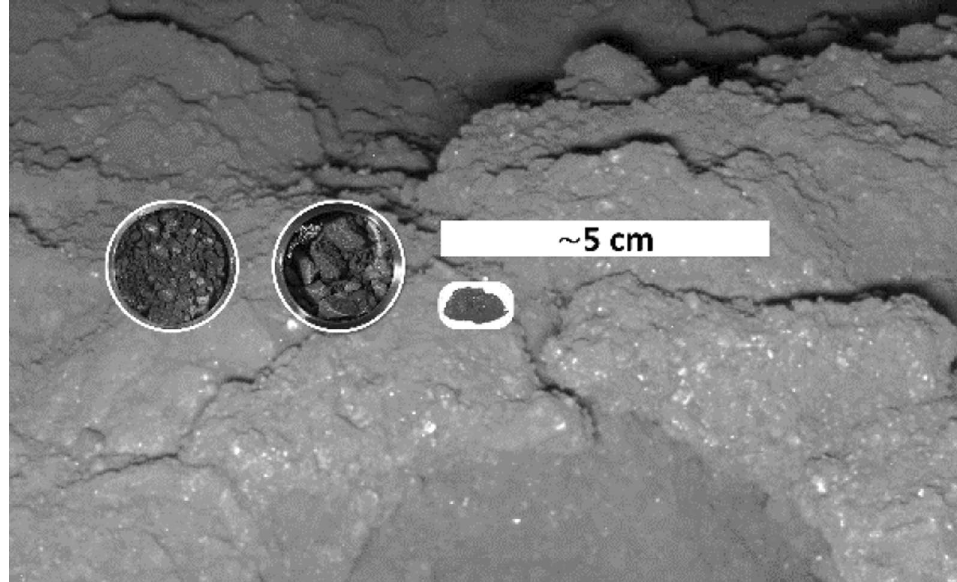
Fig. 3 Rock illuminated by MasCam’s red LED at night in relation to the returned sample. Sub‑millimetre‑sized bright spots are clearly visible in the front. The two circles illustrate the ~ 1.7 cm across opening of the sample holders with the returned samples. The largest returned fragment (C9000) with 1 cm in size is also shown for reference. Due to the distortion in the MasCam image, the dimensions of the samples and the MASCOT scene are only approximately to scale at the indicated location. Please note that the samples were not collected at this site and are shown here for reference only. The images of the samples were retrieved from (Astromaterials Science Research Group (ASRG)